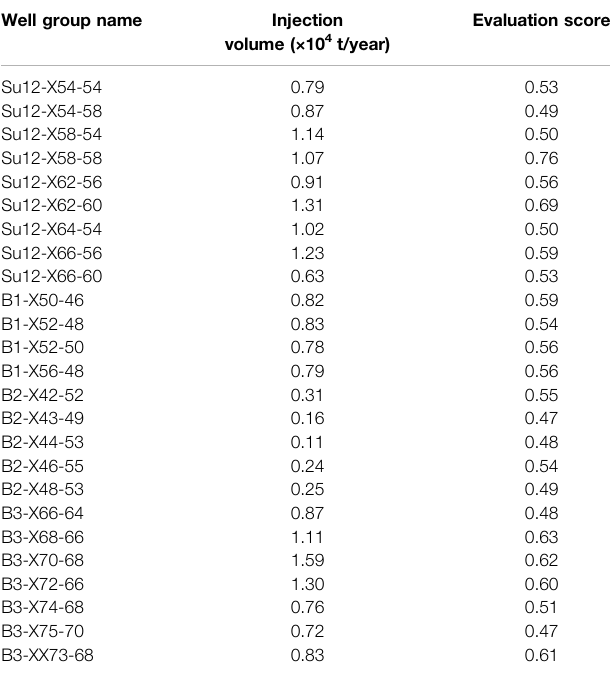
TABLE 7 | CO 2 fl ooding scoring for low-permeability reservoirs in the Daqing Oil fi eld. Well group name